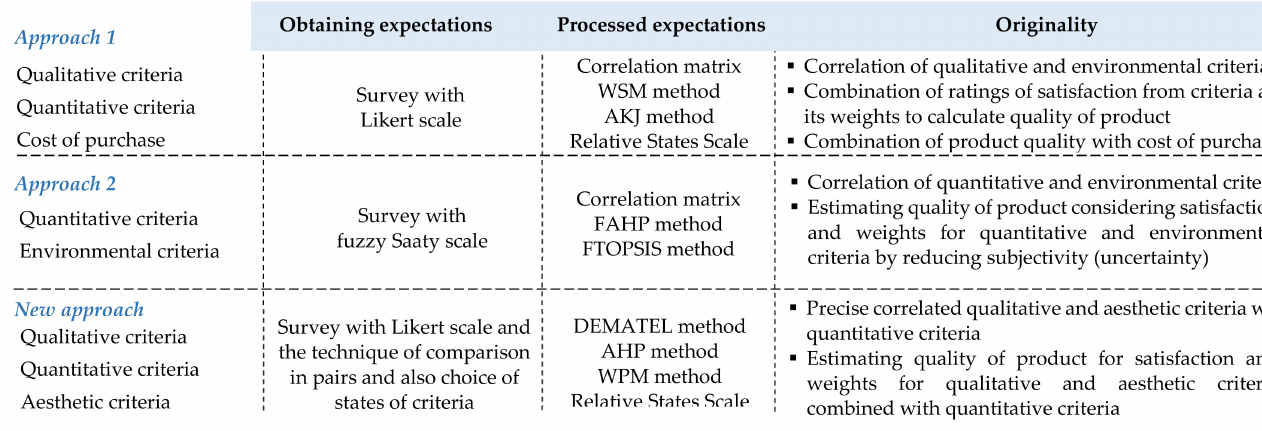
Figure 1. Originality of work in comparison with previous works. Own study based on